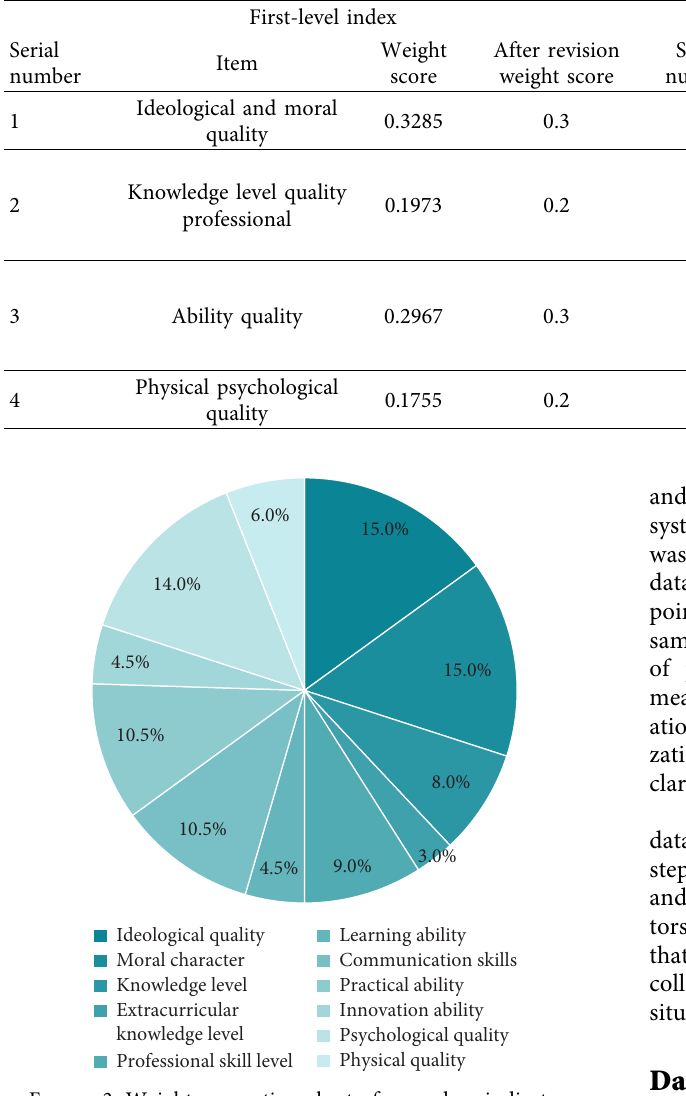
Figure 3: Weight proportion chart of secondary